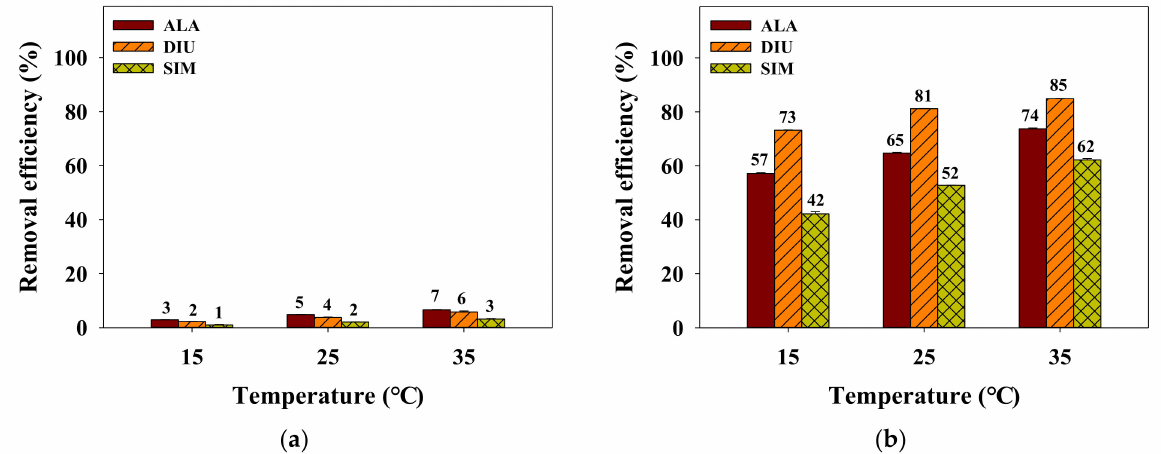
Figure 8. The effects of the solution temperature on the removal of the herbicides by ( a ) the GCRB and ( b ) GCRB-N (agitation speed = 150 rpm, contact period = 24 h, absorbent dosage = 50 mg/L, initial concentration of each herbicide = 10 µ M, and pH